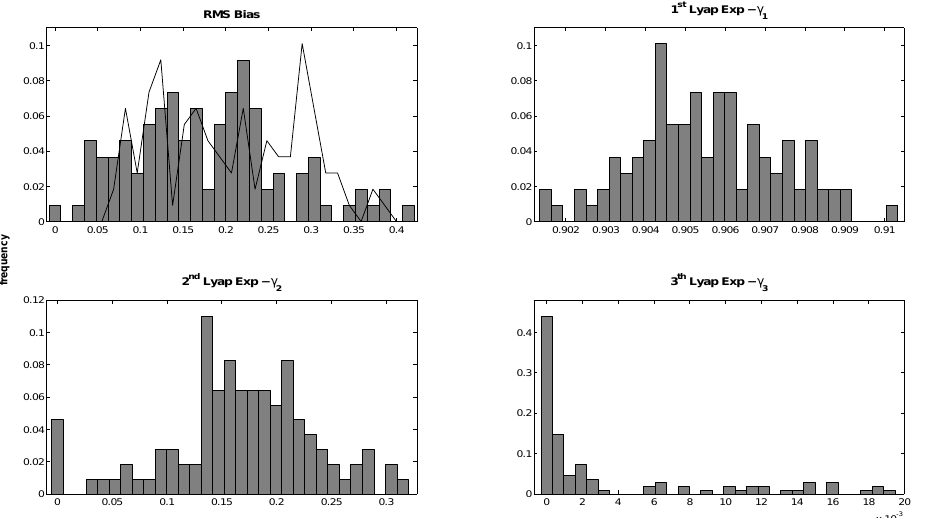
Fig. 1. Distribution of the RMS bias (top-left panel) and of the first, second and third Lyapunov exponents. The solid line in the top-left panel shows the distribution of the estimated RMS bias used in the AI.